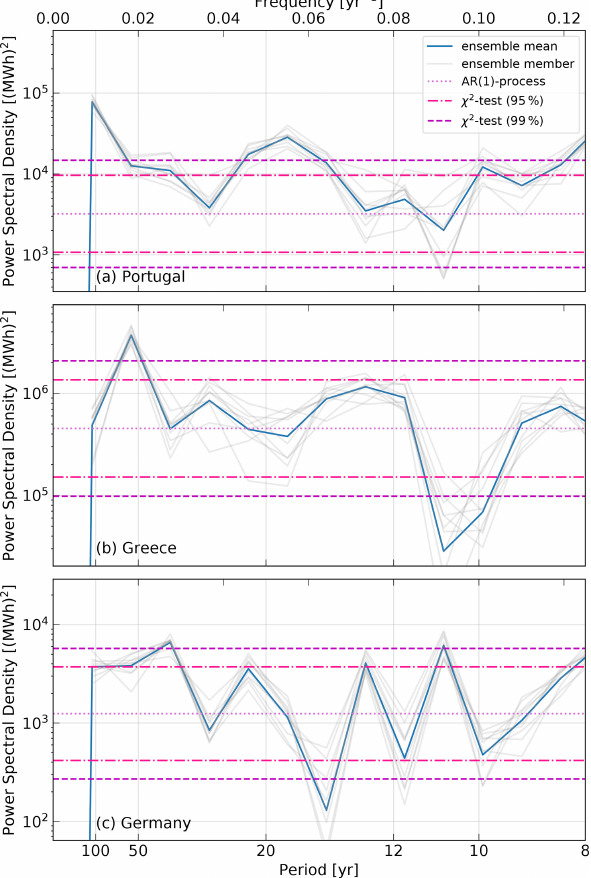
Figure 2. Wind power potential spectra of three locations in Eu- rope. Each panel shows the PSD for offshore wind power potential in the 20th century (blue denotes ensemble mean, gray ensemble members) in a multi-decadal range: (a) Portuguese Atlantic Coast, (b) Greek Mediterranean, (c) German North Sea. An AR ( 1 ) -process models the noise and an applied χ 2 -test gives confidence intervals of 95% (dashed) and 99%